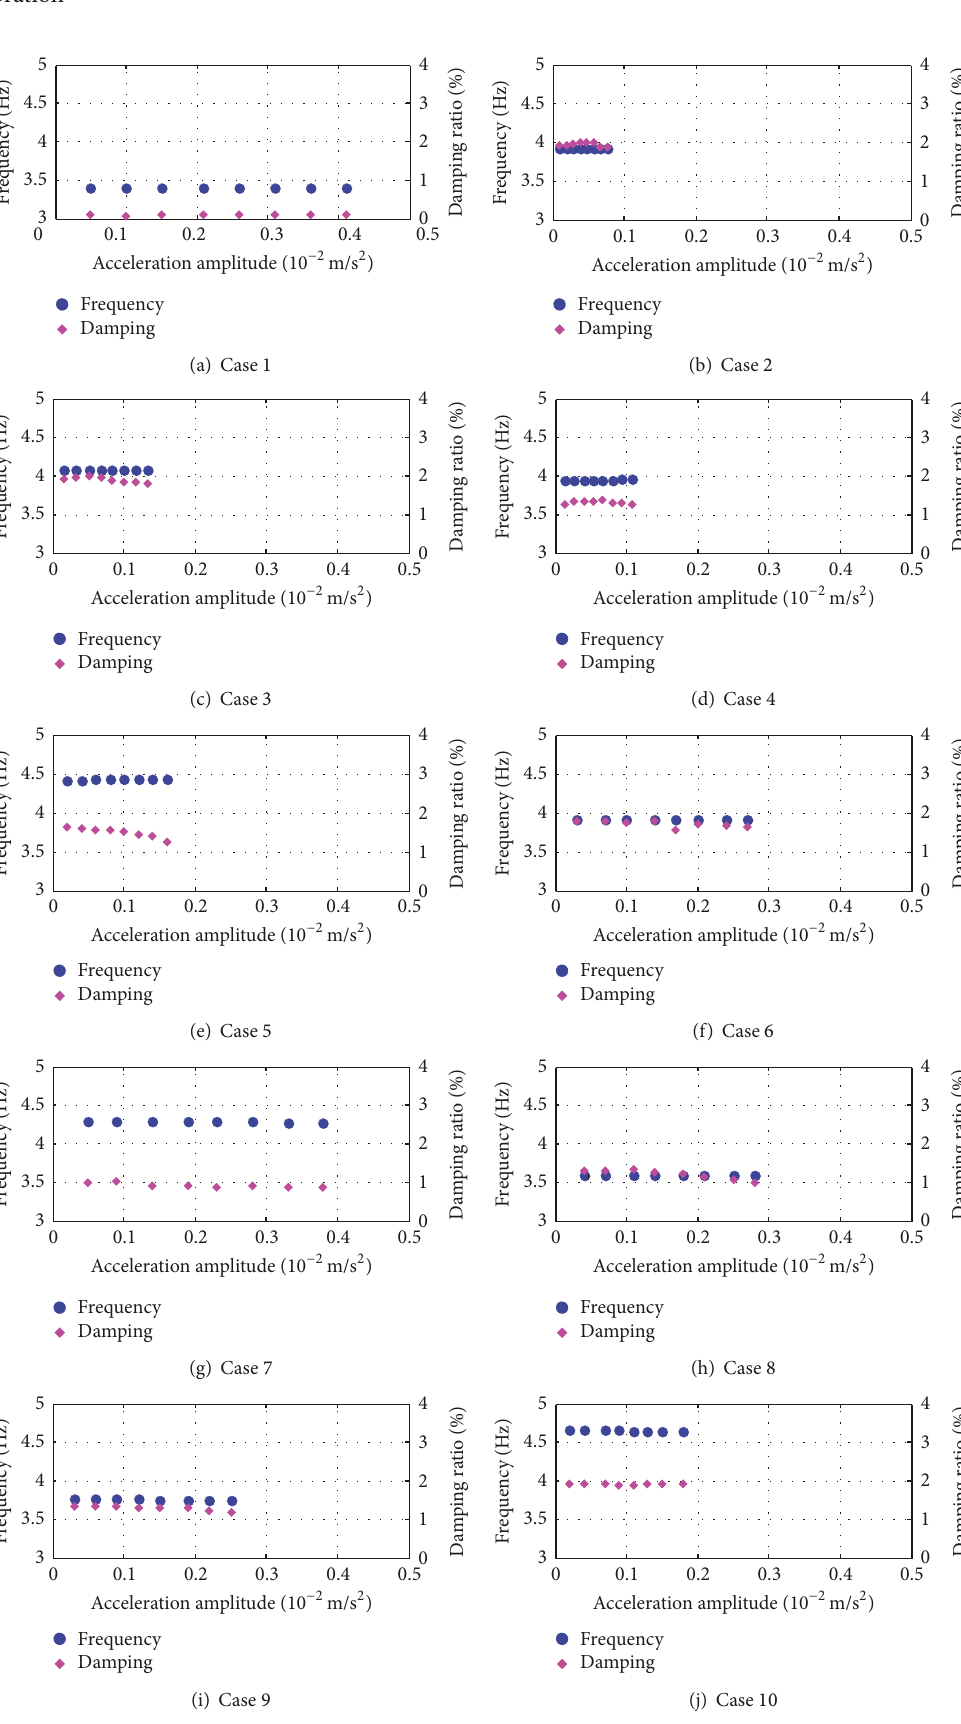
Figure 9: Amplitude-dependent dynamic characteristics estimated from ambient vibration